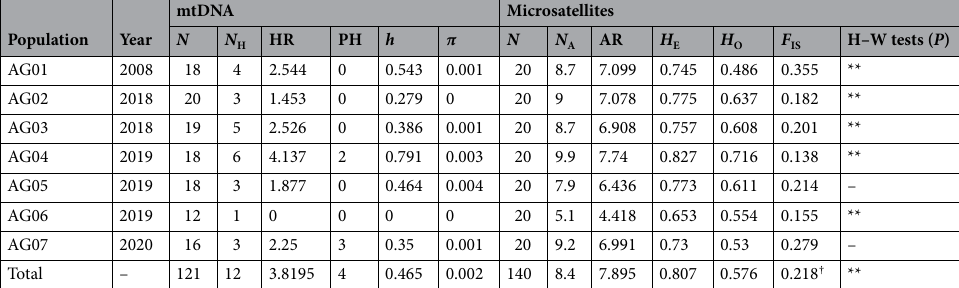
Table 3. Summary of genetic diversity statistics in seven populations of Asynapta groverae in South Korea at both the mitochondrial COI region and ten novel microsatellite loci. mtDNA, Mitochondrial DNA; N , Sample size; N H , Number of haplotypes; HR, Haplotype richness; PH, Number of private haplotypes; h , Haplotype diversity, π, Nucleotide diversity; N A , Observed mean number of alleles across eight loci; AR, Allelic richness; H E , Expected heterozygosity; H O , Observed heterozygosity; F IS , Observed inbreeding coefficient; H–W tests ( P ), P value for multi-locus tests for Hardy–Weinberg equilibrium, average of each F IS†